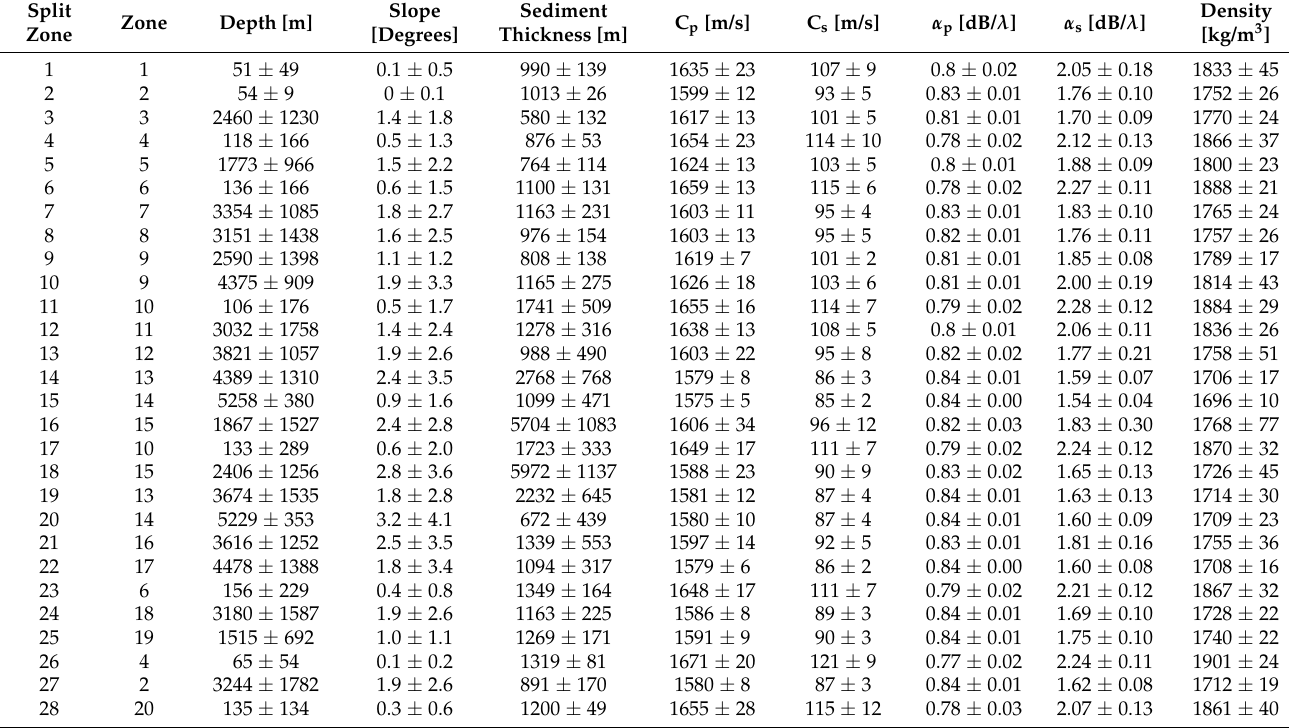
Table 1. Average parameters ( ± SD) of the 28 spatially separated acoustic zones: Water depth, seafloor slope, sediment thickness, compressional (c p ) and shear (c s ) speeds, compressional ( α p ) and shear ( α s ) absorption coefficients, and density. λ is the acoustic